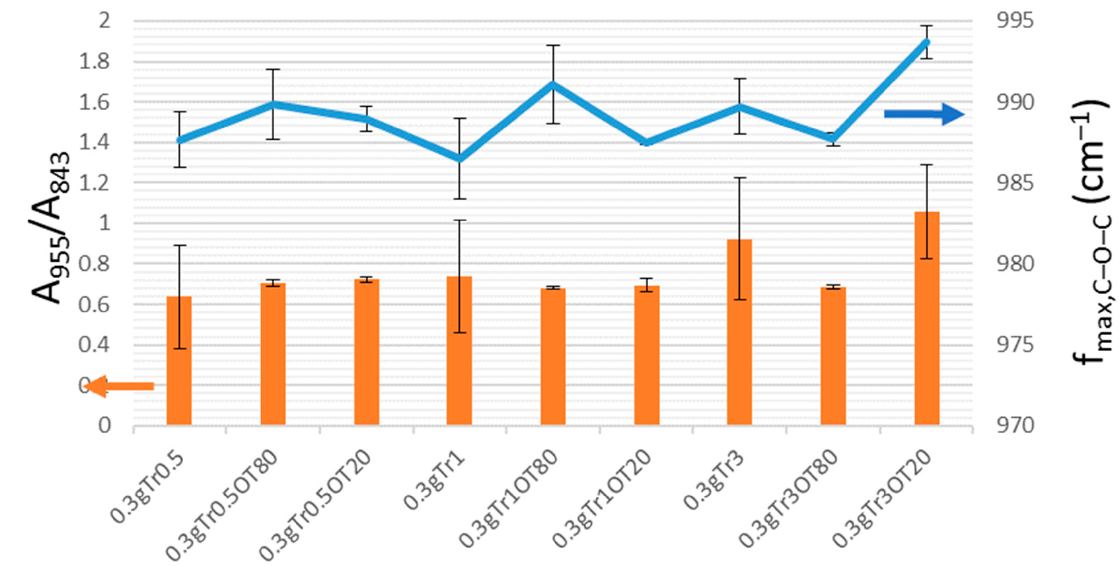
Figure 10. Quantitative crystallinity markers determined from ATR FTIR spectra of the trehalose-containing carrageenan films (0.3 g of carrageenan).